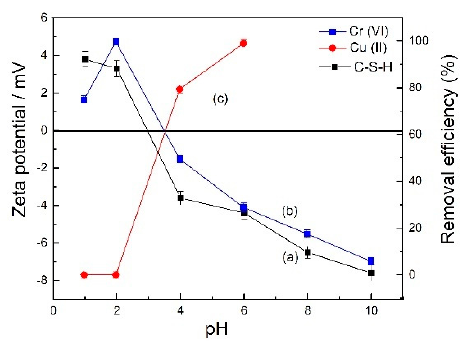
Figure 1. The zeta potential of C-S-H ( a ) and effect of pH for Cr(VI) ( b ) and Cu(II) ( c ) adsorption onto C-S-H (40 °C, [Cr(VI)] 0 = [Cu(II)] 0 = 200 mg/L, reaction time 90 min, 0.1 g C-S-H for Cr(VI), 0.07 g C-S-H for Cu(II)).